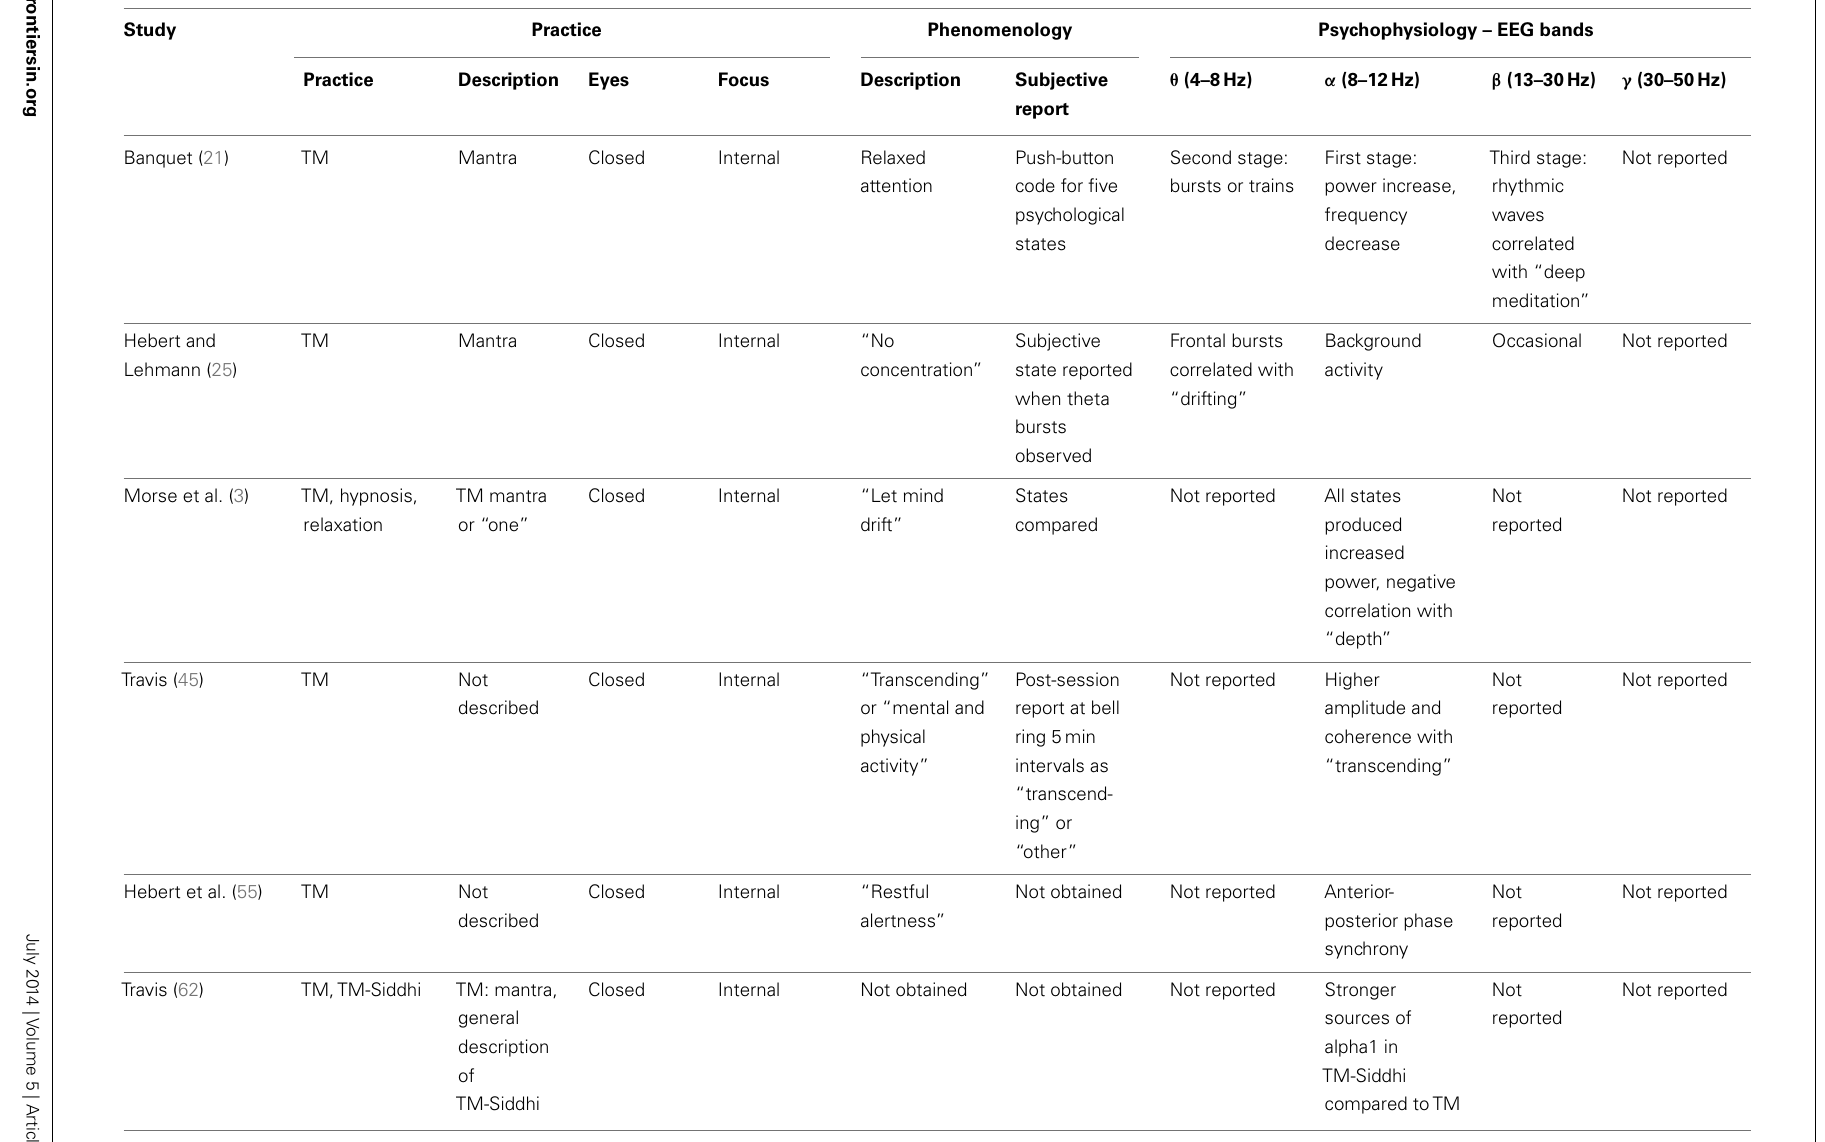
Table 4 | Studies using transcendental meditation